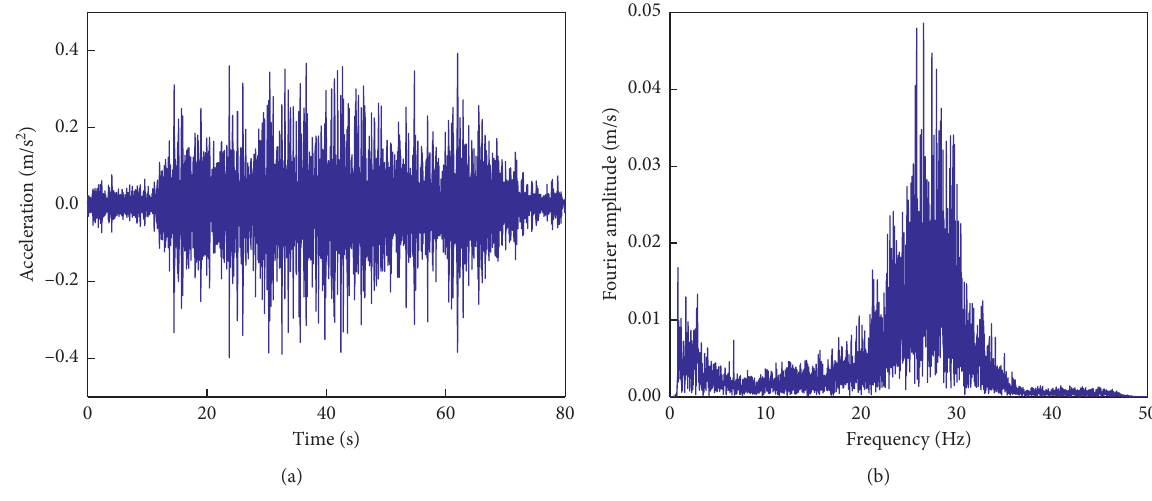
Figure 6: WC wave: (a) time history; (b) Fourier spectrum. Table 4: Seismic wave input